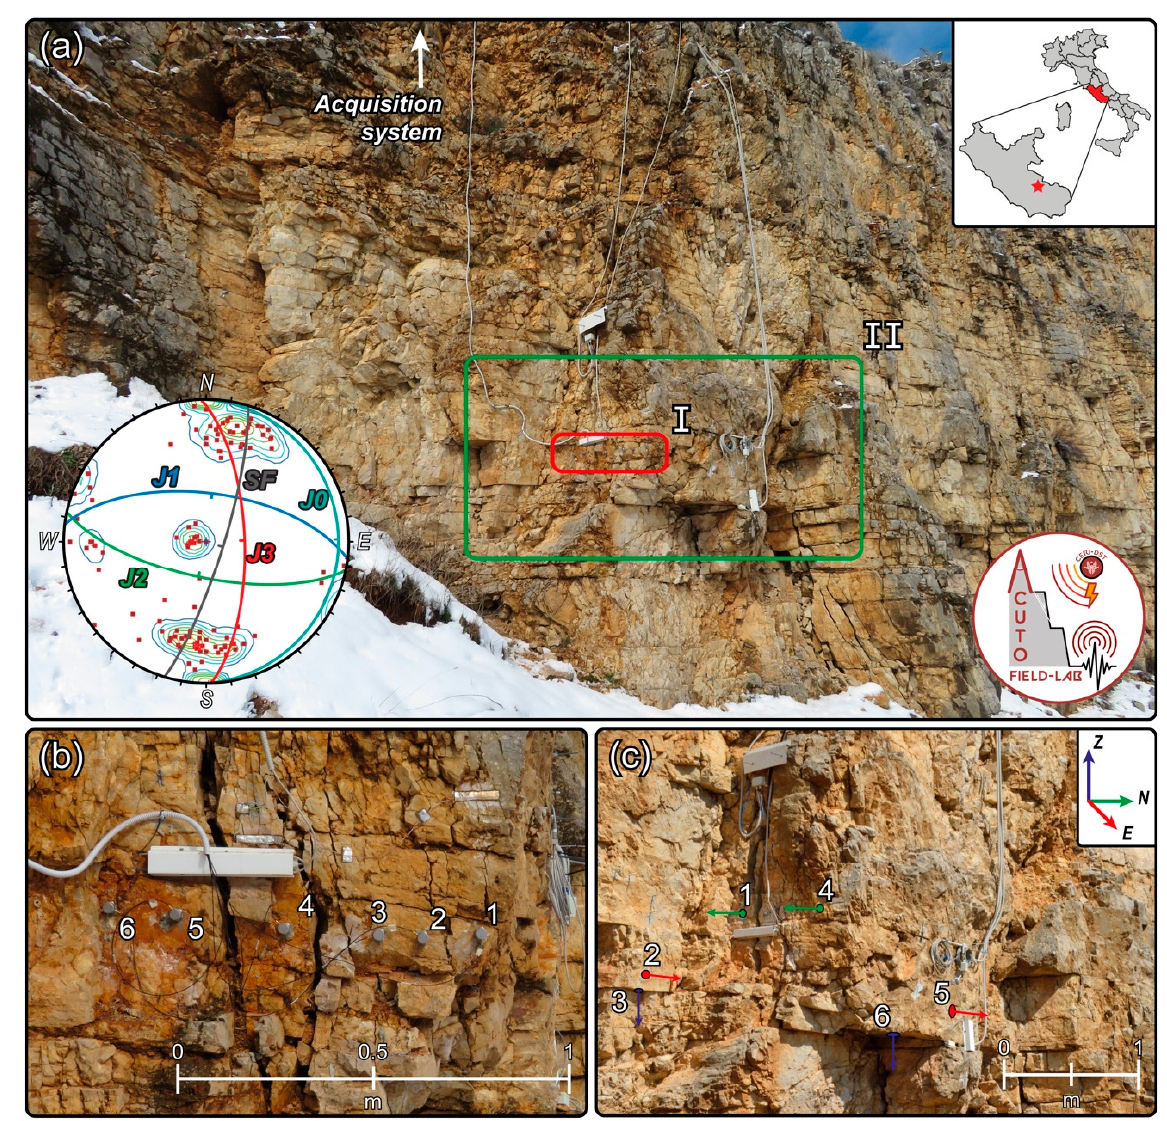
Figure 2. View of the monitored jointed rock block at the Acuto field laboratory (https://www.dst.uniroma1.it/en/structures/laboratories/NaturalLaboratoryAcuto) along with the stereographic projection (equal-angle lower hemisphere) of pole density distributions and planes of the four main discontinuity sets (SF: slope face) ( a ). The two boxes help to better visualize the different volumes involved by the configurations adopted during the first (I, red box) and the second monitoring campaign (II, green box). Between February and May 2018, six micro-accelerometers (1–6) were deployed along a linear alignment specifically designed to mark the transition from the stable rock mass to the unstable rock block ( b ). The second monitoring campaign (November 2018–October 2019) was conducted by installing six micro-accelerometers (1–6) in a “composite” double three-component configuration ( c ).